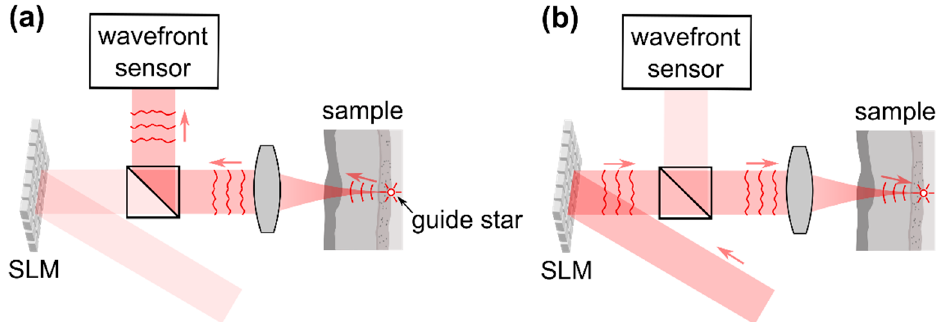
Figure 4. Principle of digital optical phase conjugation. ( a ) Light emitted from a point-like guide star is detected after transmission through the scattering layer. In contrast to adaptive optics, high-resolution wavefront sensing techniques such as phase-shifting interferometry are used. ( b ) A spatial light modulator allows one to propagate the phase-conjugated wavefront back to the sample. A focal spot at the position of the original guide star is created. Image from [8], with permission.